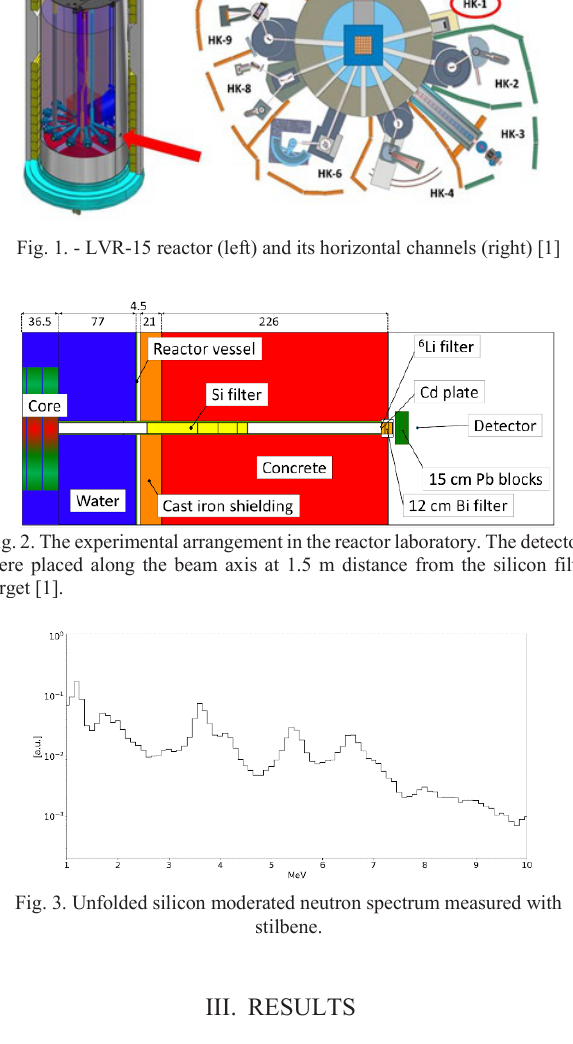
Integration method based on the pulse charge